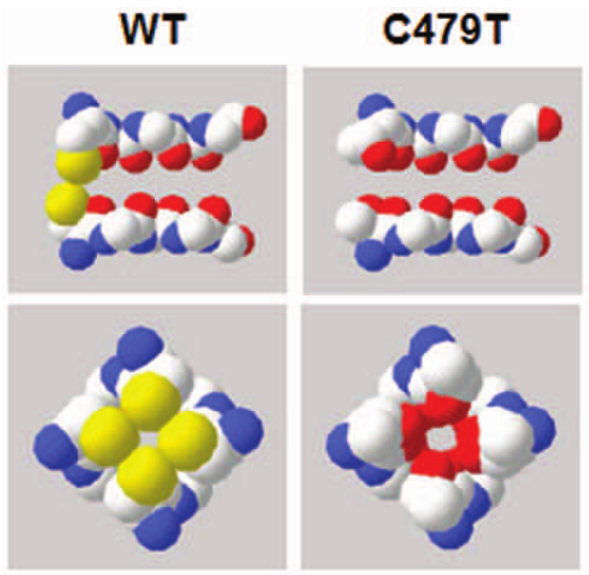
Figure 7. Proposed pore topology in WT and C479T HCN4 channels. A space filled model of the pore sequence in WT and C479T HCN4 channels based on the model of mHCN2 (Giorgetti et al. , 2005). The top two panels depict a side view of this sequence in these channels with the intracellular side of the channel on the left. The bottom panels depict a bottom up view of the pore in these channels. The bulk of the 2 SH group (yellow) in WT HCN4 would limit the pore diameter, and provide a steric barrier thereby limiting ionic permeation and selectivity based on hydrated ionic radius. The C479T mutation increases the pore diameter from 5.4 A˚ in WT (at the edge of the electron clouds) to 6.2 A˚ and reduces the steric barrier for ion permeation and ionic selectivity based on effective